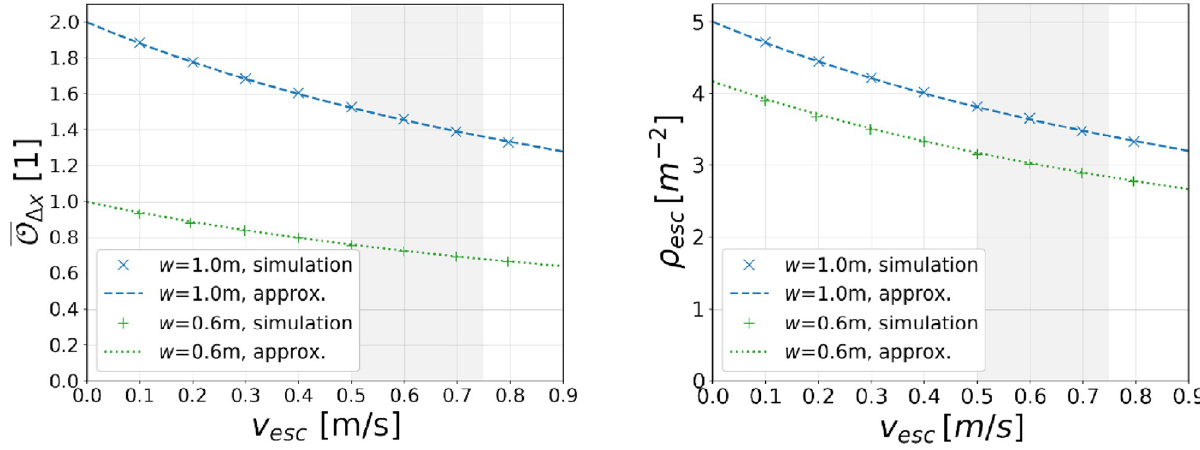
Fig 7. Speed dependence of the step occupancy. The simulation results are obtained from Eq (10) by using results of the spatial separation in movement direction from the previous section. The respective approximations follow from Eq (11) using T = 0.25s, d step = 0.4 m, O ¼ 2 for w = 1.0 m, and O ¼ 1 for w = 0.6